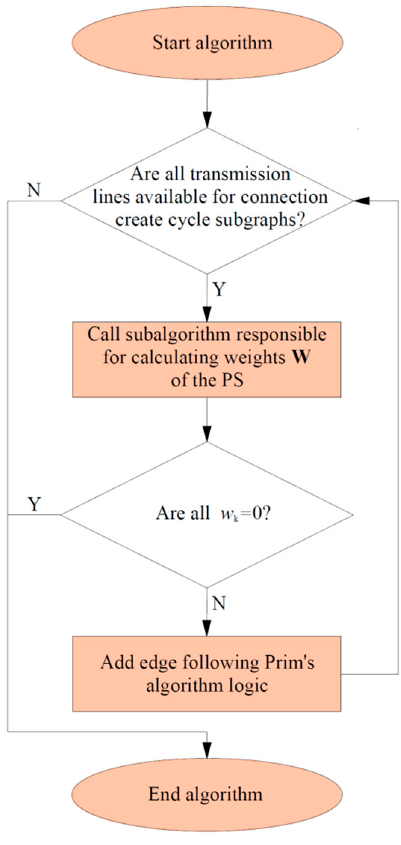
Figure 5. Structure of Prim’s algorithm used in the simulation.